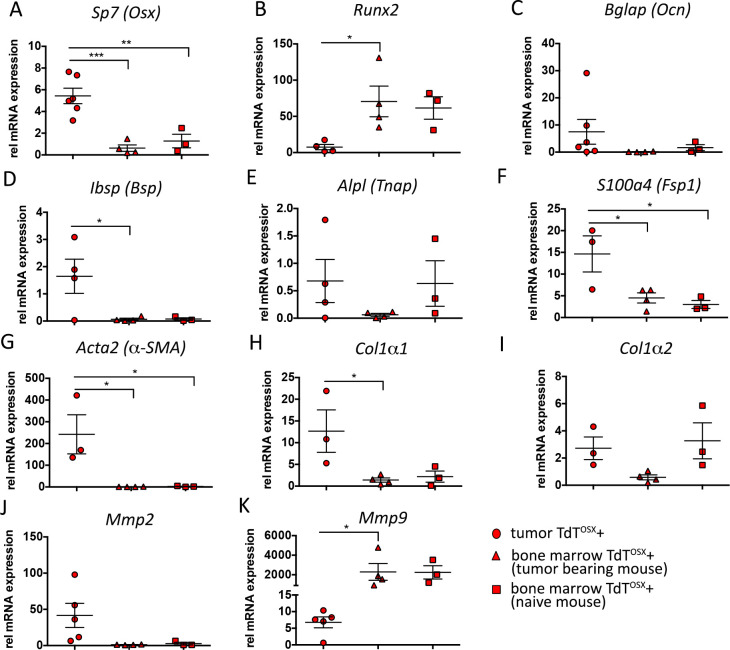
Differential expression of mesenchymal markers in TdTOSX+ cells isolated from tumor site or bone marrow.(A–K) Quantitative Real-Time PCR for (A) Sp7 (Osterix), (B) Runx2, (C) Bglap (Osteocalcin), (D) Ibsp (Bone sialoprotein), (E) Alpl (Tnap, Tissue non-specific alkaline phosphatase), (F) S100a4 (Fsp1), (G) Acta2 (α-SMA), (H) Collagen 1a1, (I) Collagen 1a2, (J) Mmp2 (Metalloproteinase2) and (K) Mmp9 (Metalloproteinase9) genes in TdTOSX+ isolated from the B16-F10 melanoma primary tumors, bone marrow of B16-F10 bearing mice and bone marrow of naïve tumor-free mice.Figure 3—figure supplement 2—source data 1.Relates to Real-Time PCR.